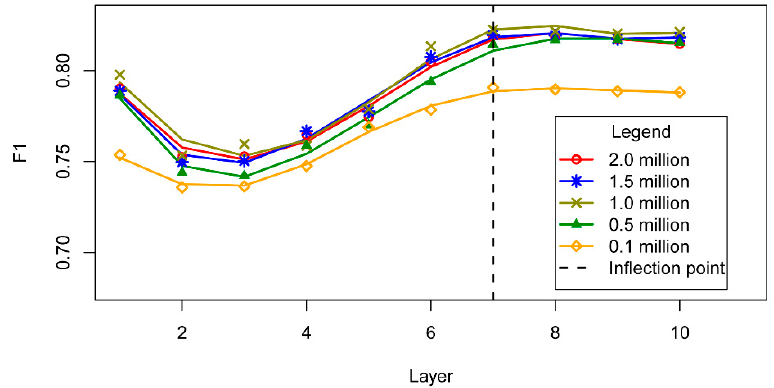
Figure 8. The relationship between the number of layers and F1 values.